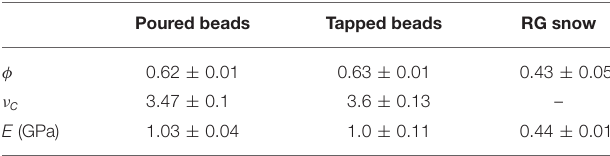
TABLE 2 | Mean and standard deviation of the ice volume fraction φ , contact density ν c and elastic modulus E . Poured beads Tapped beads RG snow